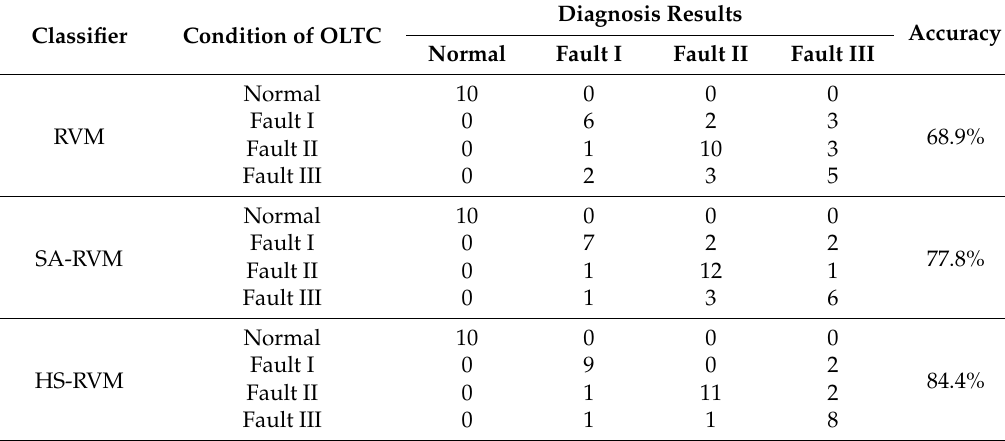
Table 6. The comparisons of test set diagnostic results.